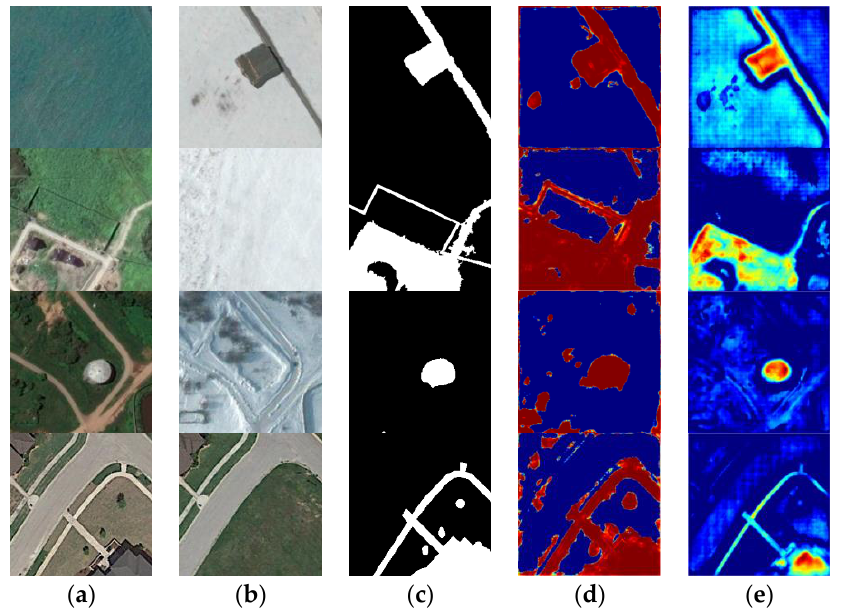
Figure 14. The heatmaps of the CCR module: ( a ) Image T1. (b) Image T2. ( c ) ground truth. ( d ) The attention map of pixel-change region relation. ( e ) The heatmap of change region contextual